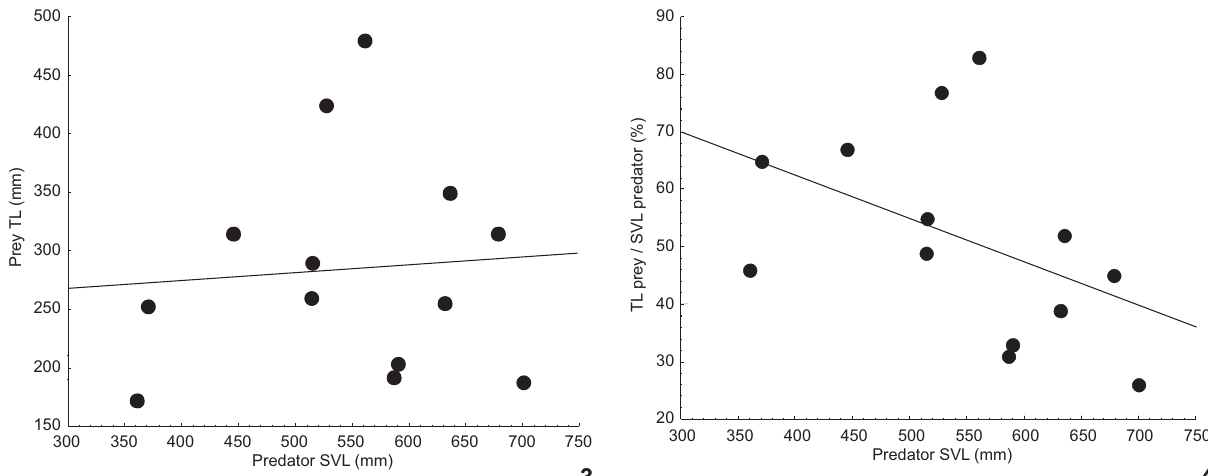
Figures 3-4. Relation between snout-vent-length of A. scytale and the: (3) total length of its items; (4) proportion of the total length of the prey in relation to the snout-vent length of A. scytale in Brazilian Amazonia.